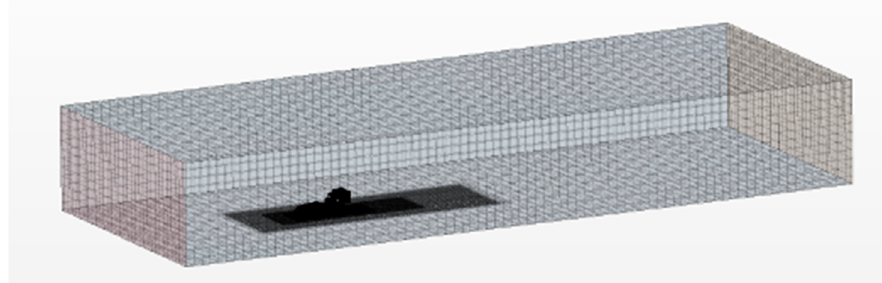
Figure 3. Volume mesh encryption domain.